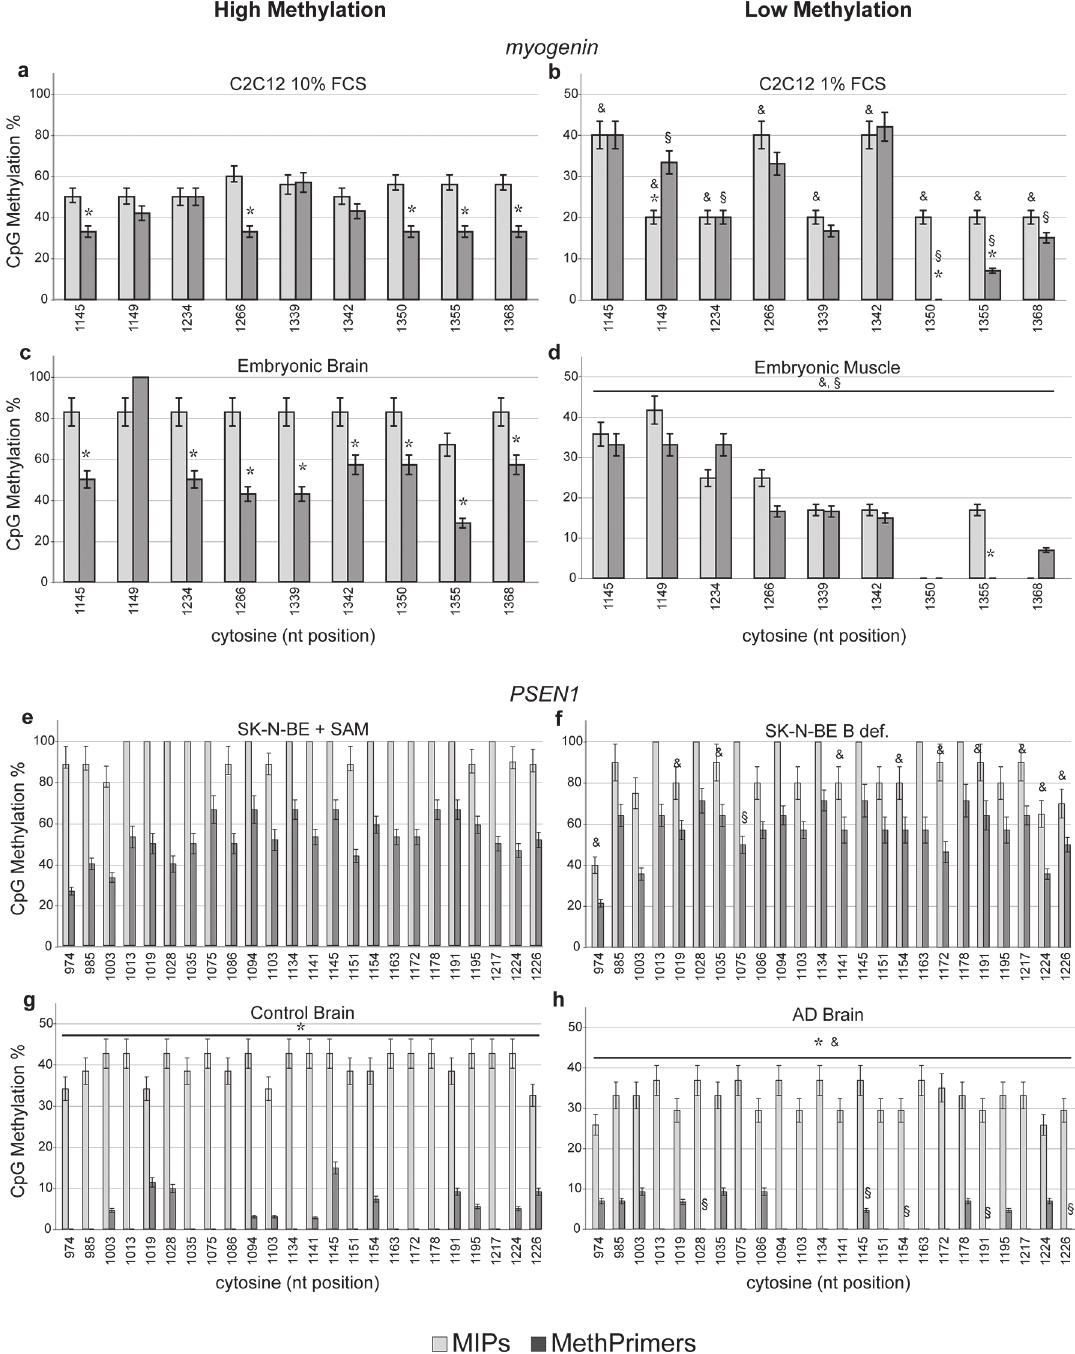
Fig 1. MIPs and MethPrimers result in different CpG methylation patterns. CpG methylation pattern is expressed as percent methylation for each CpG in the investigated region of the mouse myogenin (a-d) and human PSEN1 (e-h) promoters. Light grey columns show the values obtained using MIPs, dark grey columns show the values obtained using MethPrimers. Time points for cell cultures are: 48 h for C2C12 10% FCS, SK-N-BE+SAM, SK-N-BE B def.; 24 h for C2C12 1%FCS. Symbols: * p < 0.05 MIPs vs. MethPrimers; &: p < 0.05 High Methylated vs. Low Methylated with MIPs; §: p < 0.05 High Methylated vs. Low Methylated with MethPrimers. Y axes in histograms have a different scale (up to 100% for high methylated samples, up to 50% for low methylated samples) in order to better evidence intra-sequence differences in cytosine methylation analyzed with Methprimers vs. MIPs.